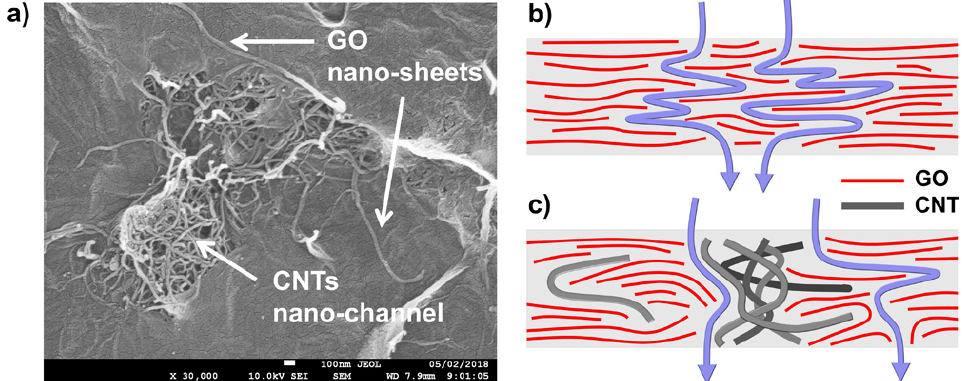
Figure 20. SEM image of entangled CNTs forming micro- and nanochannels in GO/CNTs membranes: ( a ). Flow of the solution through GO ( b ) and GO/CNTs membranes ( c ). Reproduced with permission from [187], copyright of American Chemical Society.